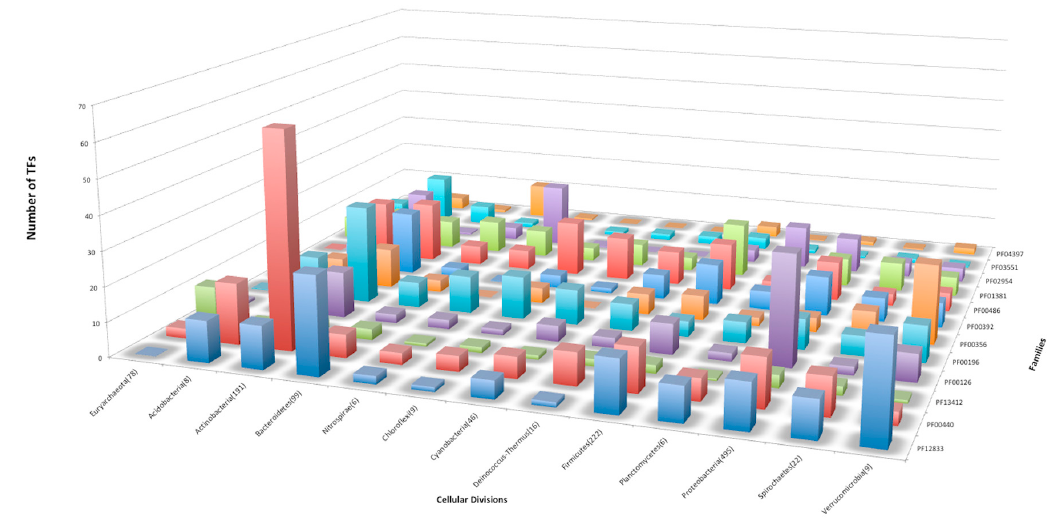
Figure 2. Families identified with more than 10 members (on average) per cellular division. The Y-axis shows the number of TFs, and the X- and Z-axes indicate the cellular division and family ID, respectively.